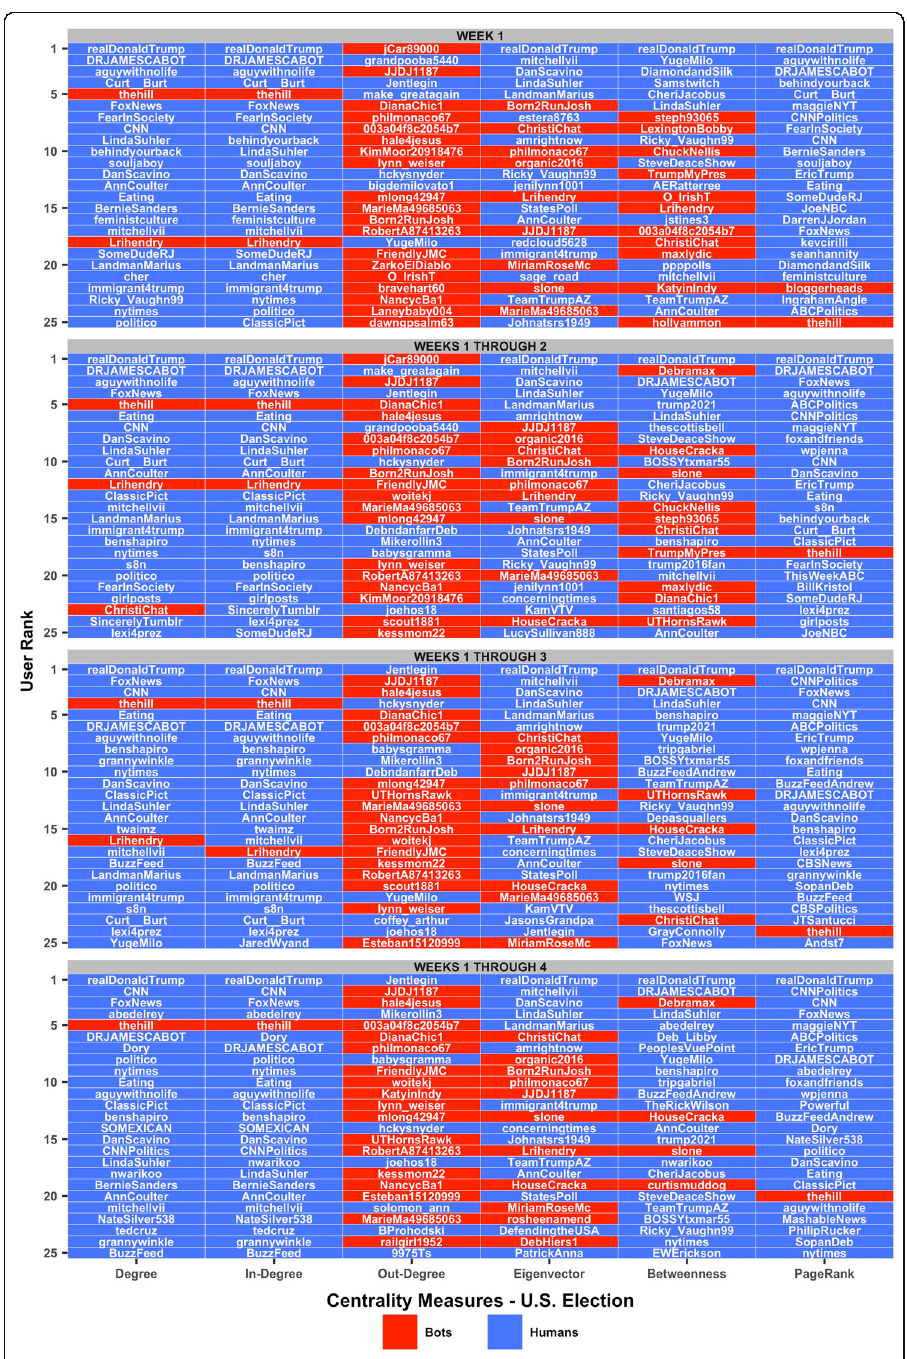
Fig. 5 Centrality ranking of top-25 bot (red) and human (blue) users over a cumulative four-week period for the U.S. Election OSN conversation for six centrality measures: (1) degree, (2) in-degree, (3) out-degree, (4) eigenvector, (5) betweenness and (6)